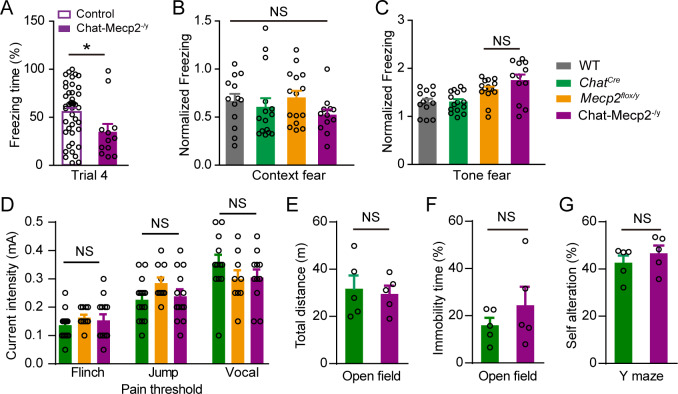
Chat-Mecp2-/y Mice Showed Normal Ability in Pain Perception, Movement Ability, and Working Memory, Related to Figure 1.(A) Chat-Mecp2-/y mice showed decreased freezing time compared to combination of other three control groups on Trial four during fear learning. P-values were calculated by two-tailed unpaired t-test. t = 2.228, df = 53, p=0.0302. n = 43 for control group, n = 12 neurons for Chat-Mecp2-/y group. (B, C) Freezing was measured against trial four during learning. P-values were calculated by one-way analysis of variance (ANOVA) with Bonferroni’s multiple comparison test. F (3, 51)=1.007, p=0.3975 for context fear. F (3, 51)=7.729, p=0.0002 for tone fear. n = 13 (WT), 15 (ChatCre), 15 (Mecp2flox/y), 12 (Chat-Mecp2-/y) mice. (D) Chat-Mecp2-/y mice showed normal response to increasing footshock intensity. P-values were calculated by one-way analysis of variance (ANOVA) with Bonferroni’s multiple comparisons test. F (2, 36)=0.8018, p=0.4563 for flinch. F (2, 35)=1.837, p=0.1743 for jump. F (2, 29)=1.044, p=0.3650 for vocal. n = 15 (ChatCre), 11 (Mecp2flox/y), 13 (Chat-Mecp2-/y) in flinch. n = 15 (ChatCre), 10 (Mecp2flox/y), 13 (Chat-Mecp2-/y) in jump. n = 12 (ChatCre), 9 (Mecp2flox/y), 11 (Chat-Mecp2-/y) in vocal. (E) Chat-Mecp2-/y mice showed normal movement ability in open field arena (15 min). P-values were calculated by two-tailed unpaired t-test. t = 0.3300, df = 8, p=0.7499. n = 5 (ChatCre), 5(Chat-Mecp2-/y). (F) Chat-Mecp2-/y mice showed normal immobility time in open field test. P-values were calculated by two-tailed unpaired t-test. t = 1.007, df = 8, p=0.3436. n = 5 (ChatCre), 5 (Chat-Mecp2-/y). (G) Chat-Mecp2-/y mice showed normal working memory in Y maze test. P-values were calculated by two-tailed unpaired t-test. t = 0.8772, df = 8, p=0.4059. n = 5 (ChatCre), 5(Chat-Mecp2-/y). Data are means ± SEM. *p<0.05, NS means no significance.